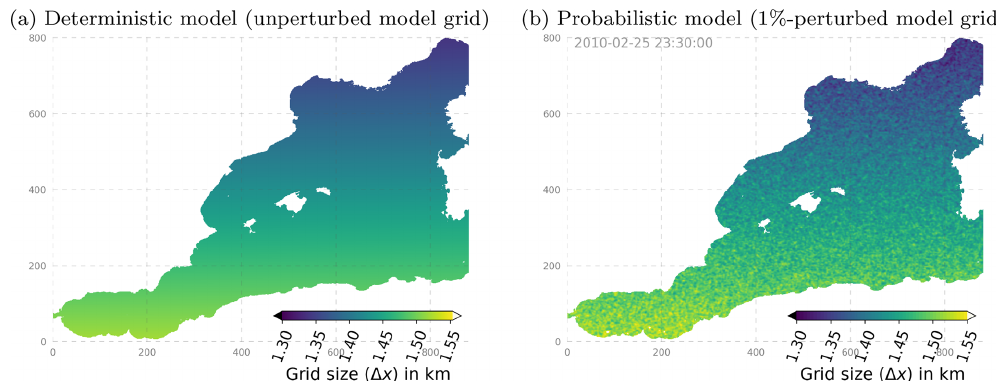
Figure 2. Size of the model grid in the horizontal east–west dimension ( (cid:49)x ): (a) unperturbed, from the standard NEMO grid at 1 / 60 ◦ resolution and (b) snapshot of the perturbed metric at a given date (stochastic perturbation set to a level of SD = 1%).